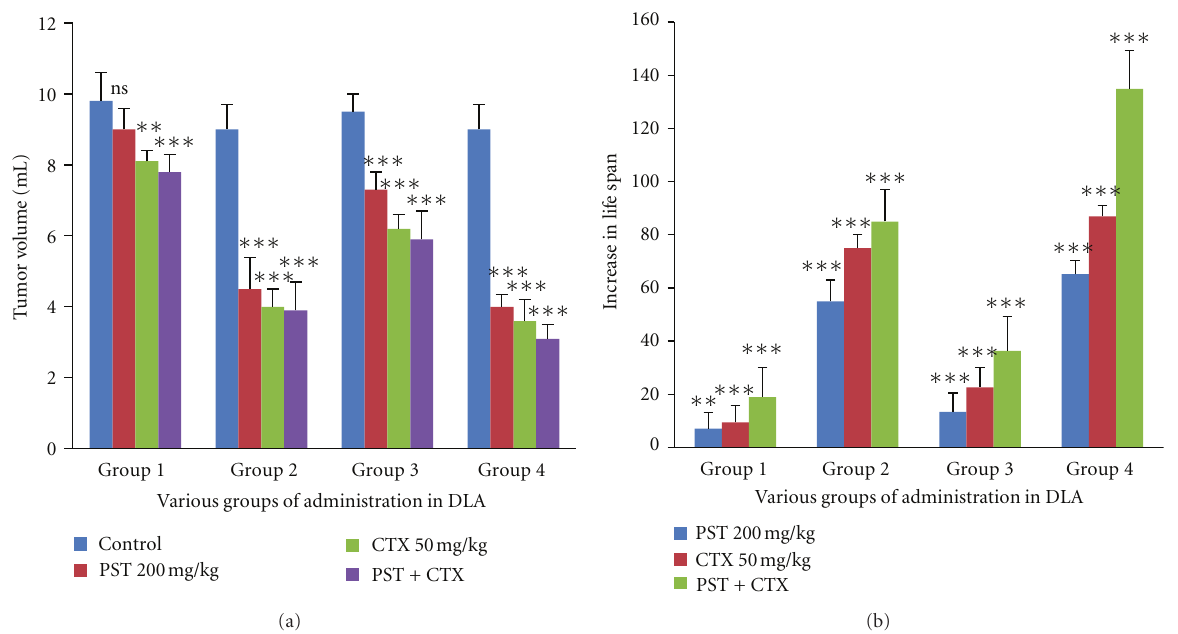
Figure 2: E ff ect of PST001 in Tumor Volume reduction and Increase in life span of various groups administered in DLA tumor bearing mice. Statistically significant di ff erences are at ∗ P < 0 . 05, ∗∗ P < 0 . 01, ∗∗∗ P < 0 . 001; ns is the nonsignificant, as compared with control group.